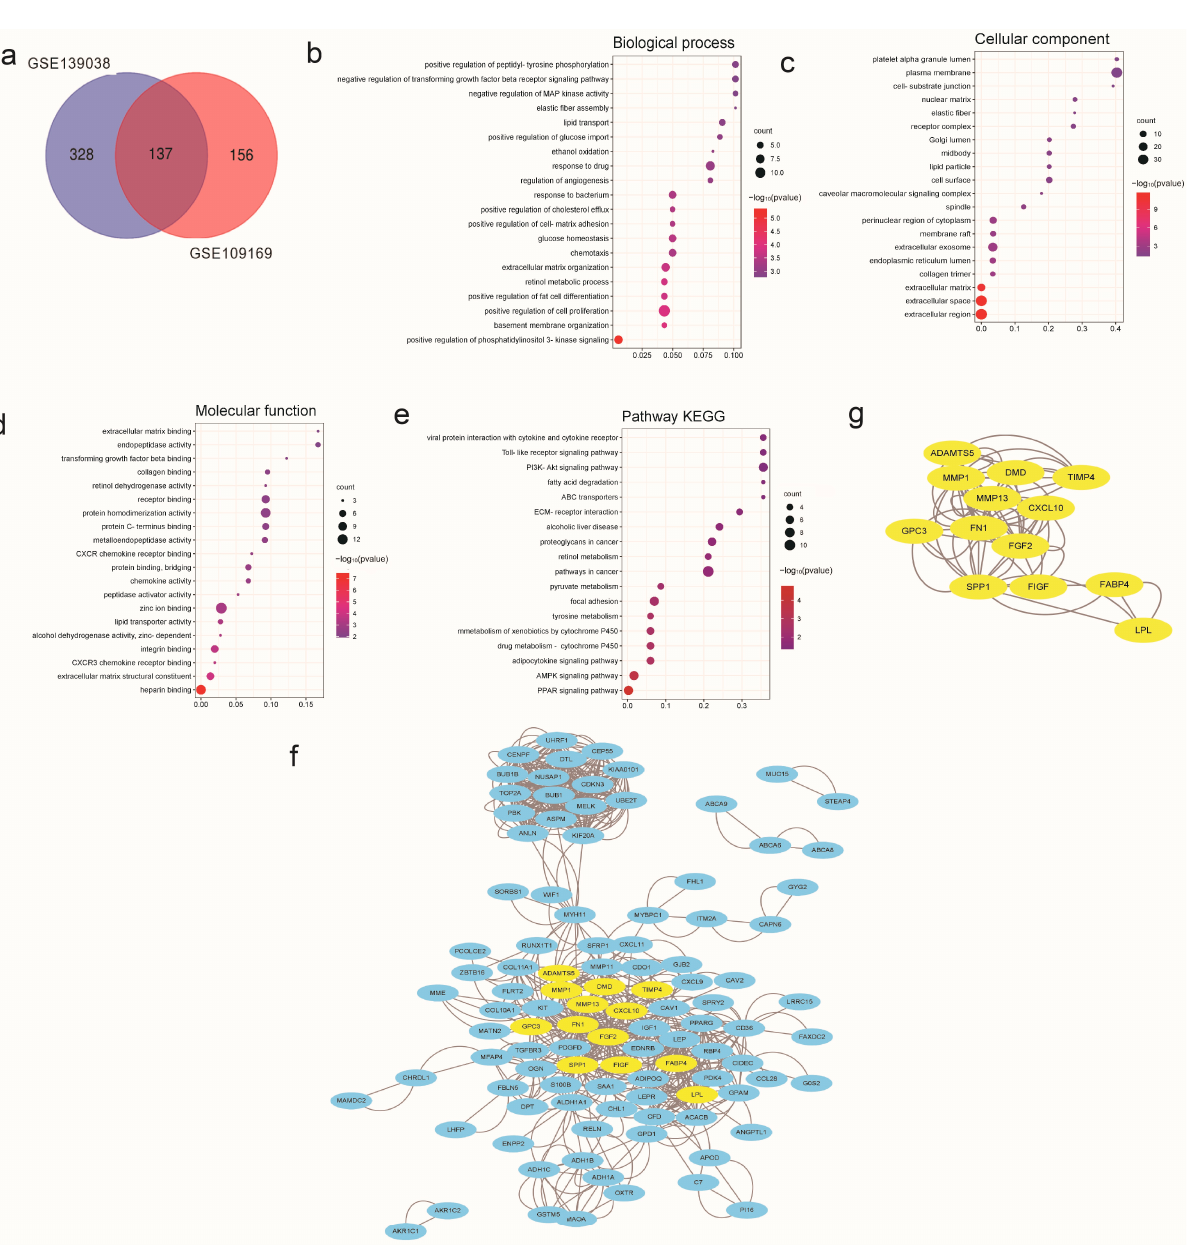
Figure 1. DEGs’ analysis associated with breast cancer in the GEO database. ( a ) The common DEGs between GSE139038 and GSE109169 are shown with a Venn diagram. ( b – e ) Bubble charts were used to show the GO and KEGG enrichment analyses for these DEGs. ( f ) Interaction network analysis of the common DEGs was performed using Cytoscape software. ( g ) Emphasizing the interaction network analysis of DEGs related to MMP1. All results are expressed as mean ± SD of three independent experiments.